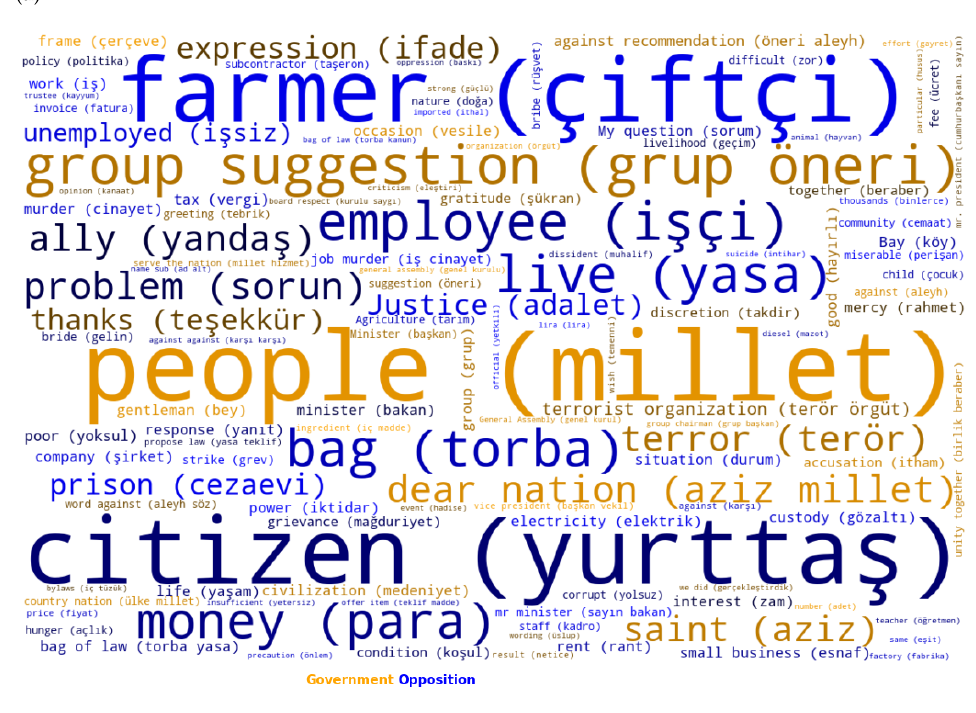
Figure 7. ( a ) Confusion matrix for party status classification with TF-IDF (word) _SVM. ( b ) Best terms of party status affiliation of